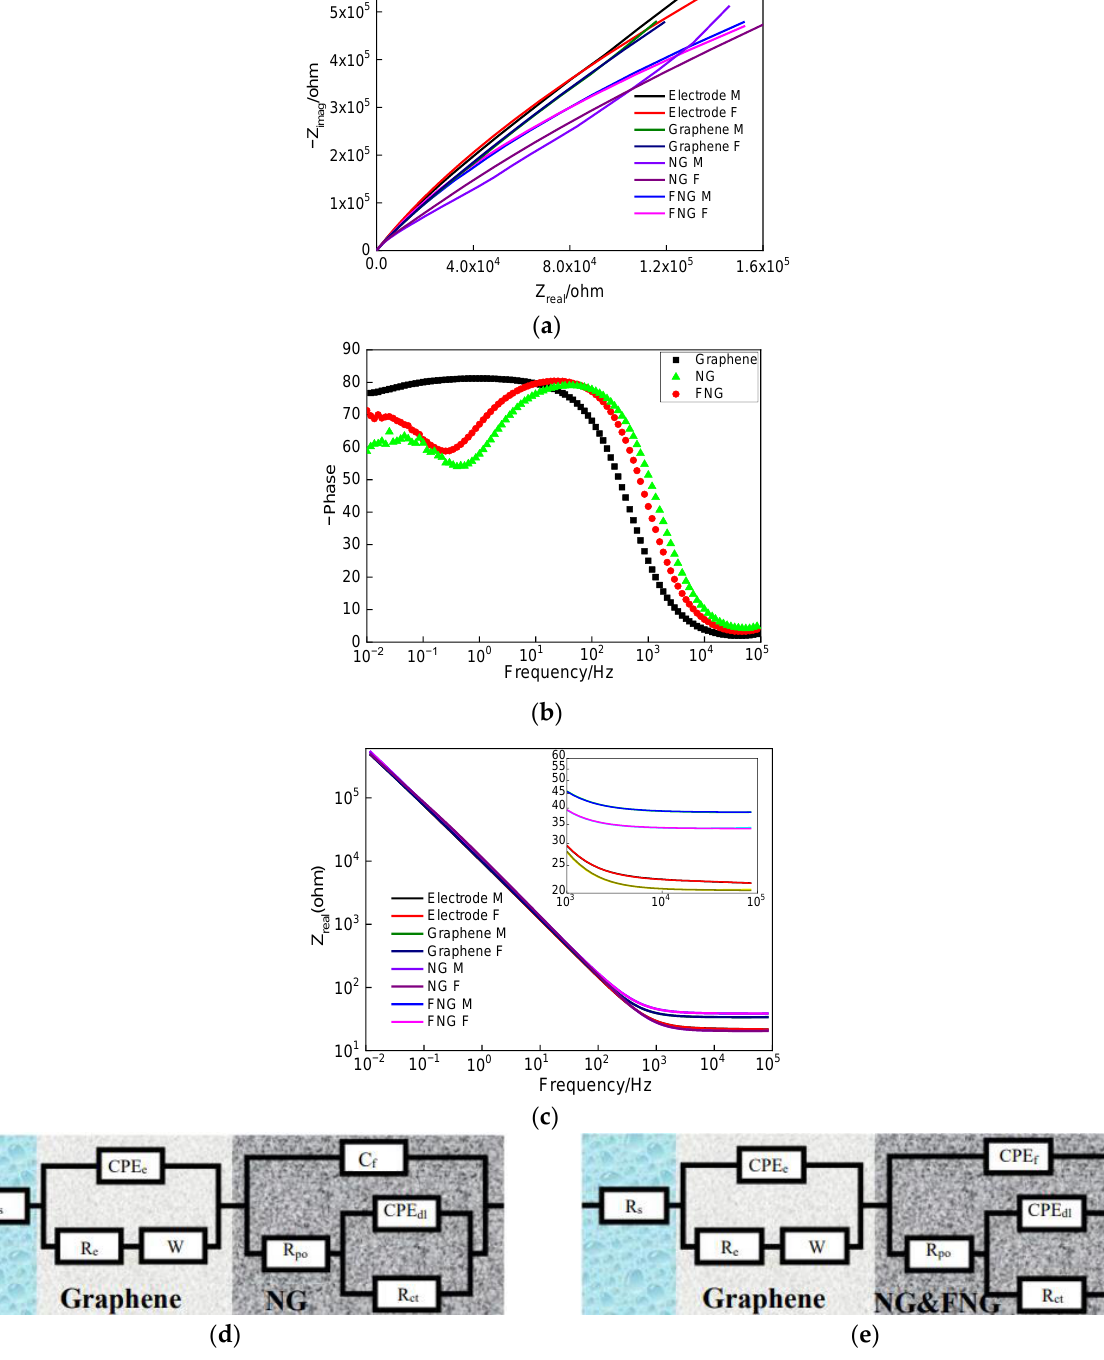
Figure 10. Nyquist curves ( a ), the relationship between frequency and phase angle ( b ), the relation- ship between frequency and impedance ( c ), and fitting circuit model ( d , e ) of graphene, NG, and FNG films.